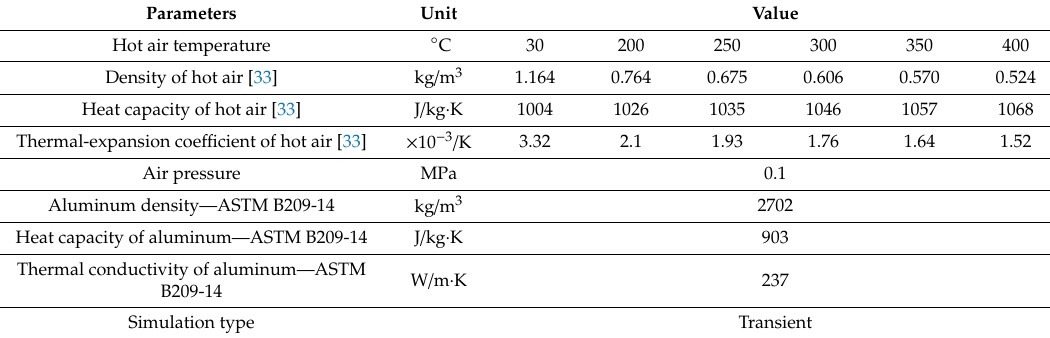
Figure 10. Simulation models for ( a ) weld line appearance and ( b ) weld line strength. Table 1. Simulation parameters for studying the heating